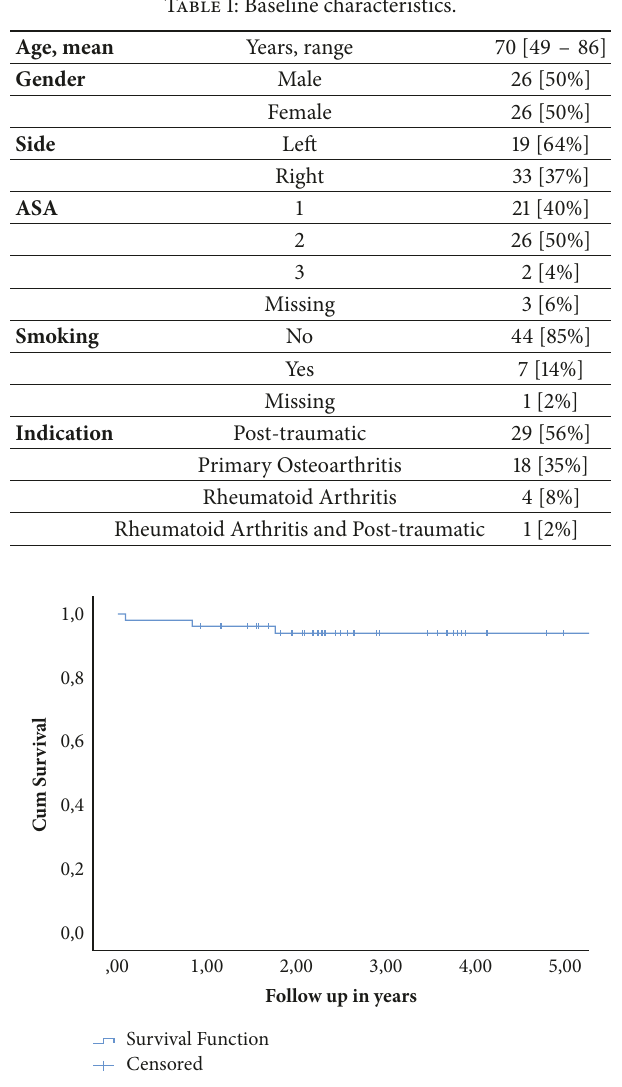
Figure 2: Survival of the TAR in years. At 2,5 years 29 were at risk and at 5 years 15 were at risk. The overall survival time is 11 with a 95% confidence interval of